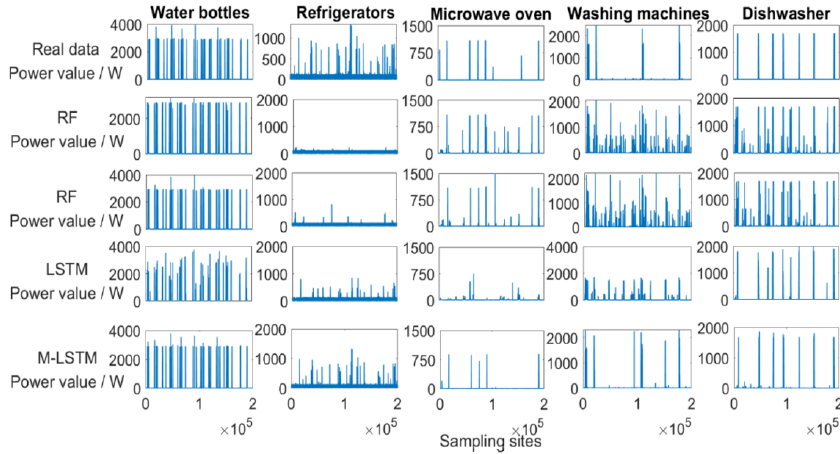
Figure 9. Comparison of UK-DALE 5 home load decomposition.